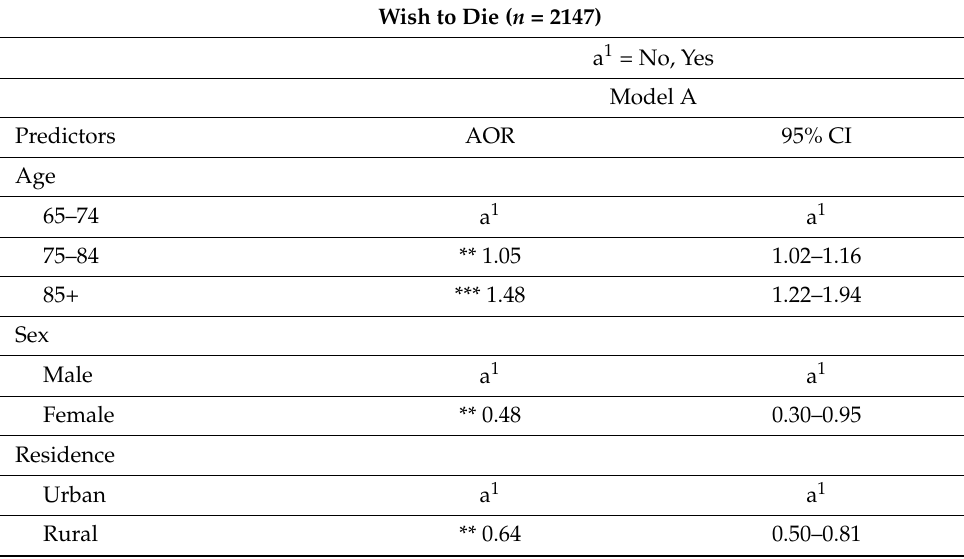
Table 2. Multivariate logit model on factors predicting the wish to